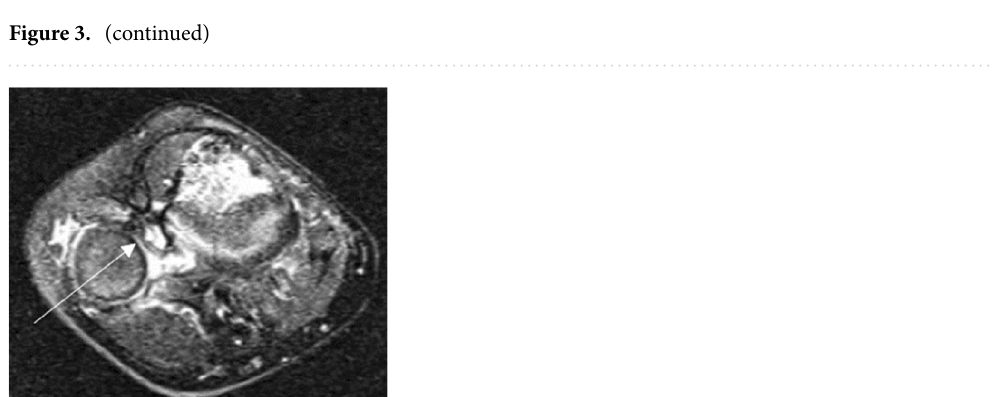
Figure 4. T2-weighted images displayed obvious tear of the annular ligament (the arrow) of the case